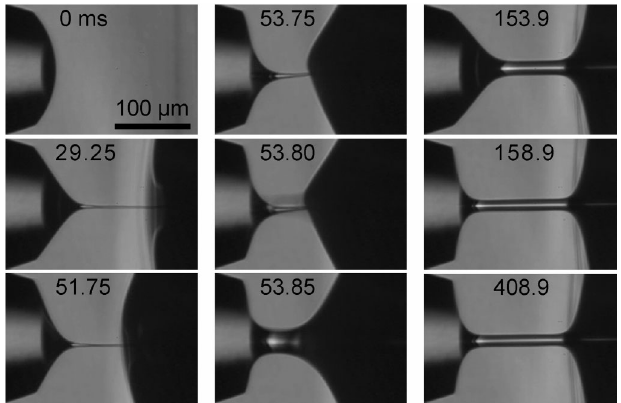
FIG. 2. The formation process of a steady cone-jet bridge. Ethylene glycol ( 10 (cid:1) S = cm ) was supplied at a flow rate of 0 : 20 mL = h , and electrified between the nozzle (grounded) and the counter electrode ( (cid:1) 1 : 4 kV ) with a separation of 0.21 mm. The diameter of the jet bridging the two cones (right column) is typically an order of magnitude higher than that of the conven- tional jet issued from a single Taylor cone (left column). These snapshots were captured from Video 1